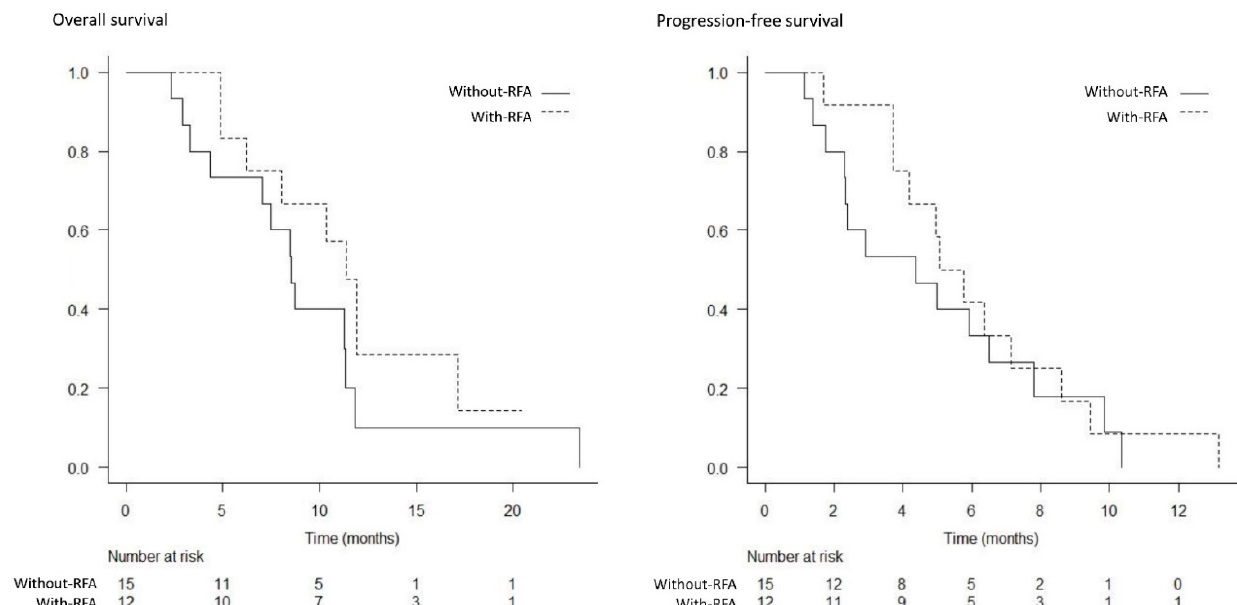
Figure 6. Kaplan–Meier analysis of the overall survival and progression-free survival in patients with metastasis. There were no significant differences in the median overall survival (11.4 months versus 8.5 months, p = 0.180) and progression-free survival (5.4 months versus 4.4 months, p = 0.529), between the with-RFA and without-RFA groups.